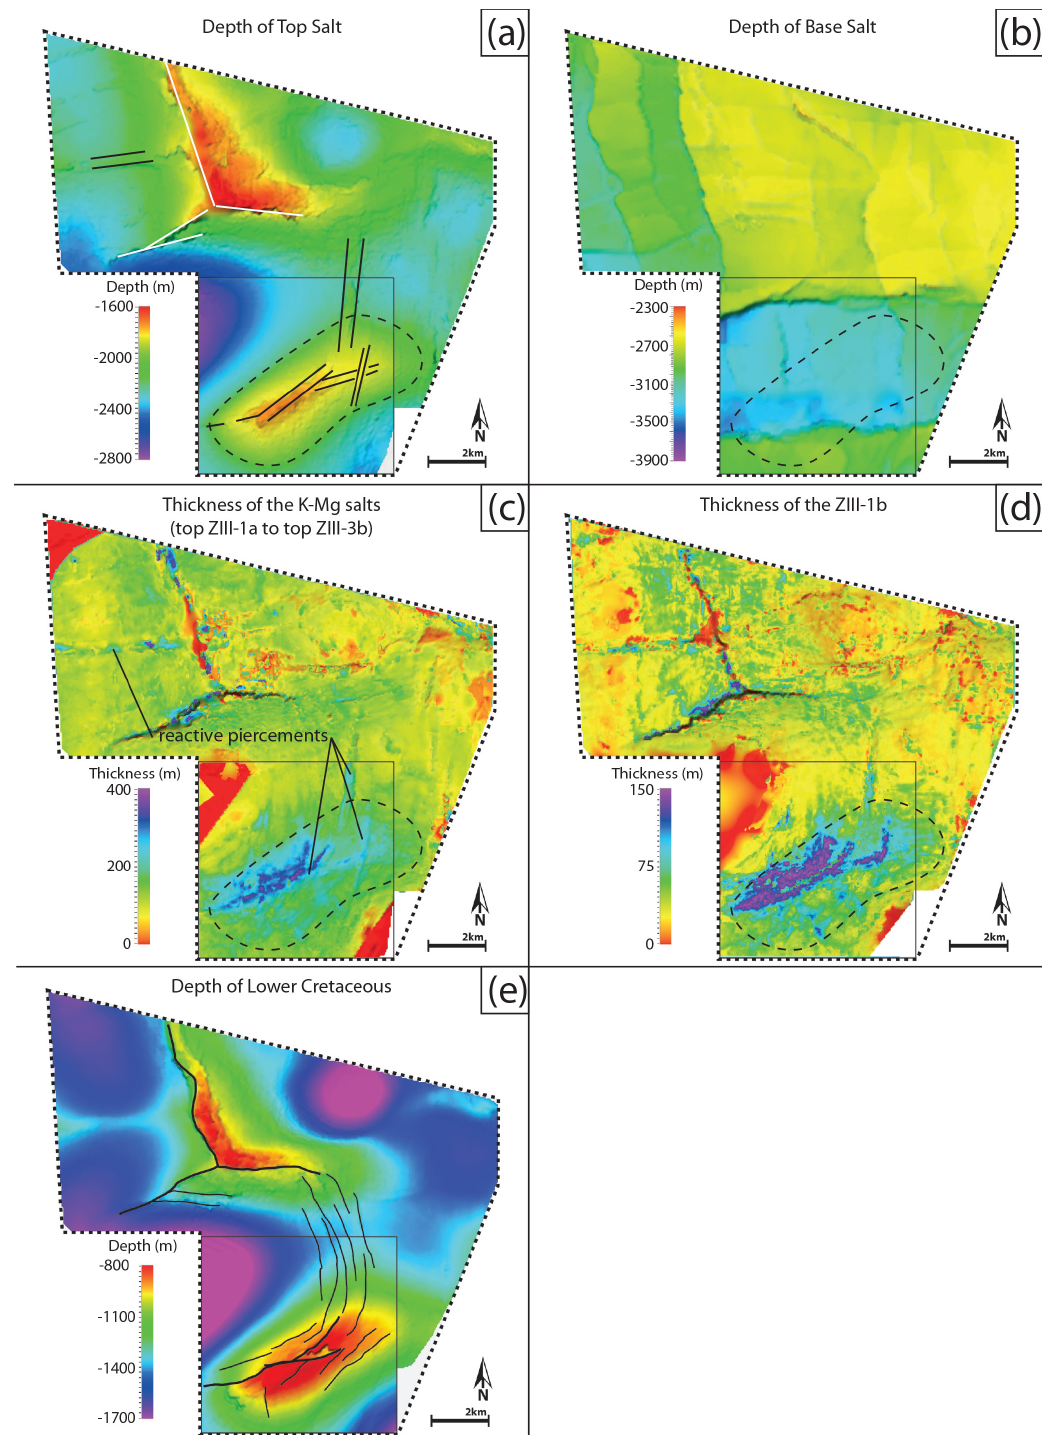
Figure 6. Detailed Top Salt map (black box indicates location of seismic volume 1) with surface inquiries (black lines) as a result of crestal collapses above salt pillows. The white lines indicate faults offsetting the Top Salt contact at the Slochteren Pillow. Thickness maps of top ZIII-1a to top ZIII-3b and top ZIII-1a to top ZIII-1b and a detailed map of the Subsalt surface (modified after Strozyk, 2014). Layers show significant thickening to the crest and under crestal collapse structures. The thickest parts are not in the middle of the crest (Veendam Pillow marked by dashed line) but on the NW flank of the Veendam Pillow towards the center of the Base Salt graben. On the depth map of the Lower Cretaceous faults offsetting the layer are marked in